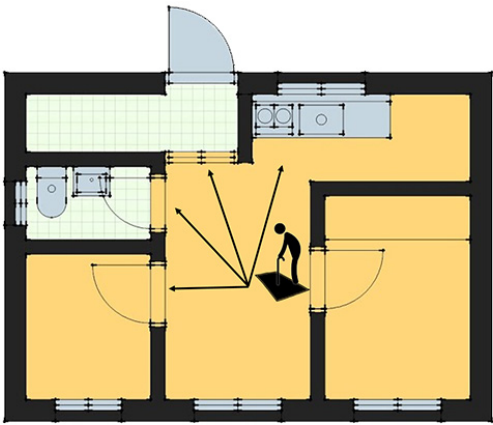
Figure 1. Suggested scenario for using a footpad in an IoT smart home.